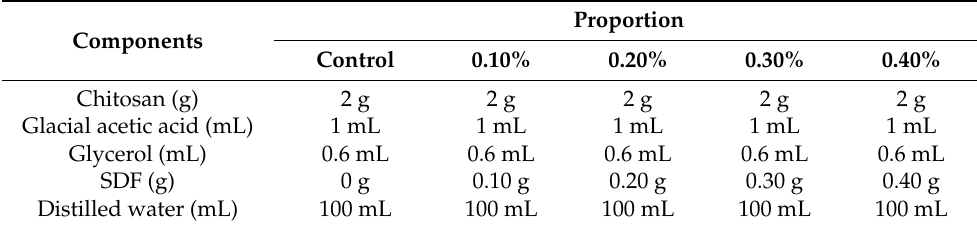
Table 1. The compositions of the SDF-chitosan coating